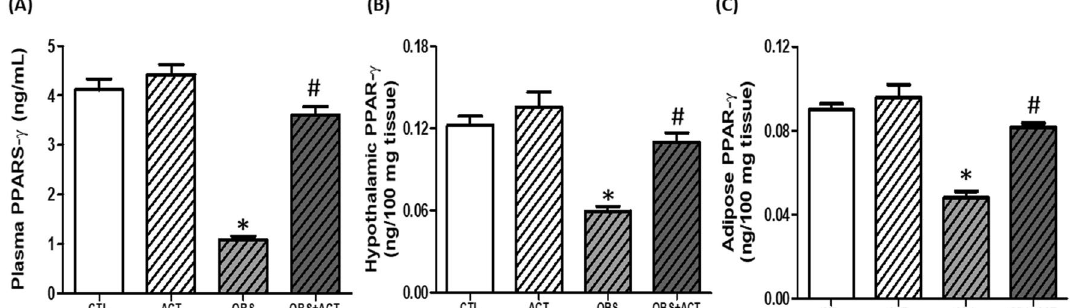
Figure 11. Effects of acetate on plasma, hypothalamic and adipose Peroxisome proliferator-activated receptor-γ ( A – C ) in high fat diet-induced obese Wistar rats. Plasma, hypothalamic and adipose PPAR-γ decreased in obese rats, which were elevated by the administration of acetate. Data are expressed as mean ± SD. n = 6 and analyzed by one-way ANOVA followed by Bonferroni post hoc test. (* p < 0.05 vs. CTL; # p < 0.05 vs. OBS). CTL Control, OBS Obesity, ACT Acetate, PPAR-γ Peroxisome proliferator-activated